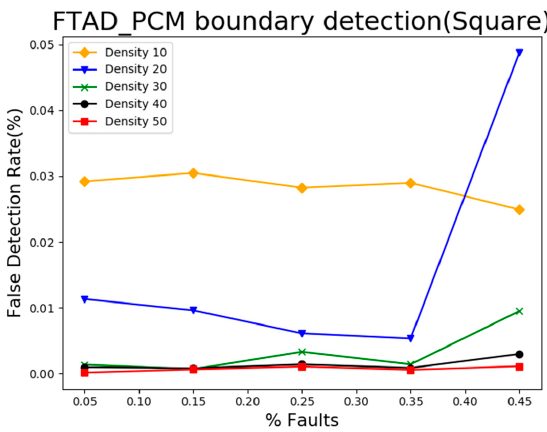
Figure 9. FTAD_PCM boundary false detection (square).